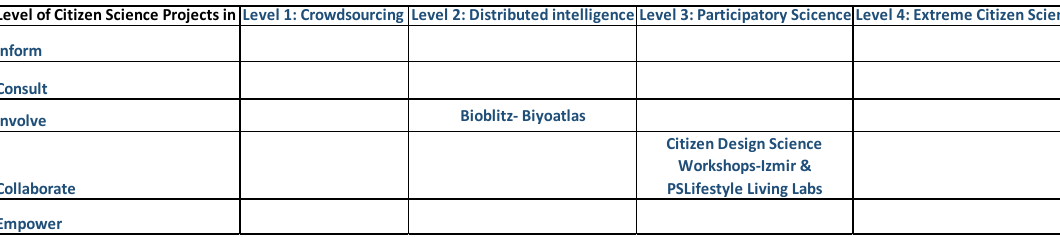
Table 1 Levels of Citizen science projects in